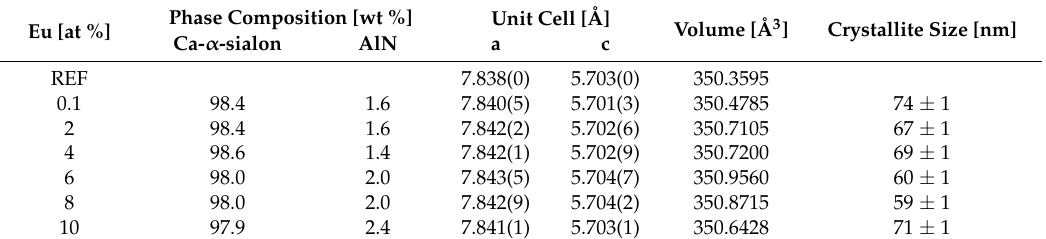
Table 1. Phase composition and lattice parameters of the samples with various amount of Eu.